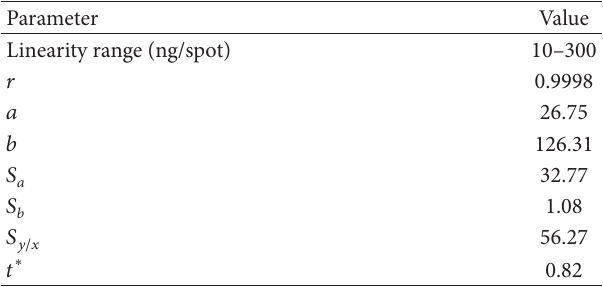
Table 2. e percentage relative standard deviation